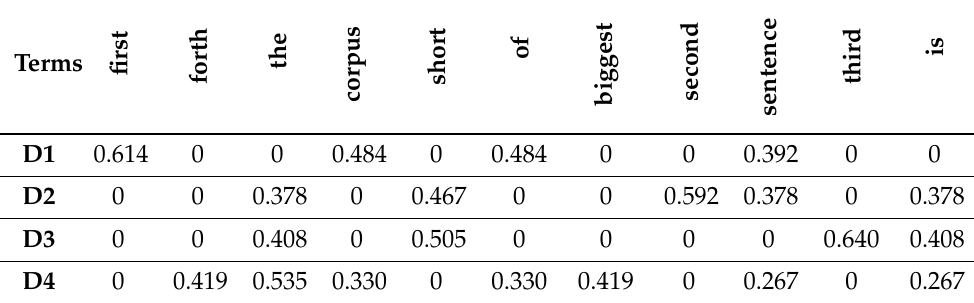
Table 7. Vector representation of the sample corpus shown in Table 4 using the Term Frequency- Inverse Document Frequency (TF-IDF)